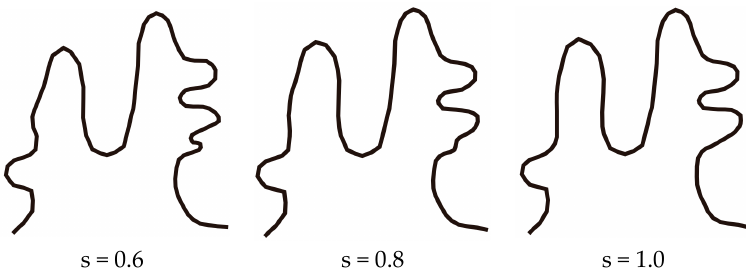
Figure 6. The morphing effect of the SABM method described in this paper.